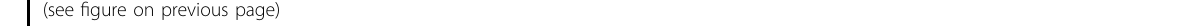
(Fig. 6d; Supplementary Fig. S6c – g). Interaction of PGRN (encoded by GRN , an antagonist of TNF α signaling) and